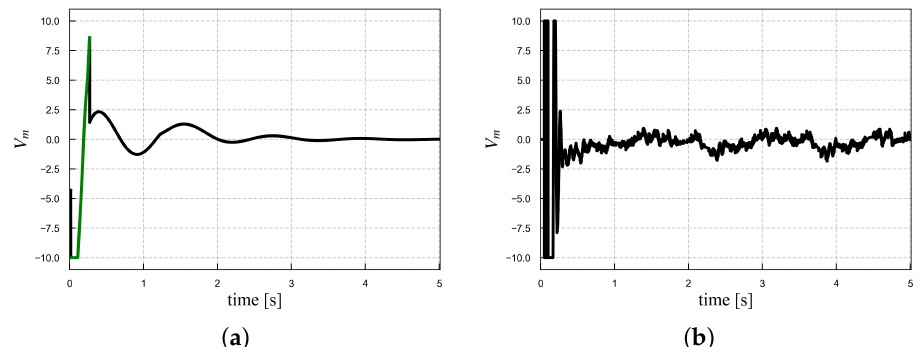
Figure 13. Algorithm 3—voltage control input—( a ) simulation (the green part of the curve indicates when the swing-up controller is active), ( b )